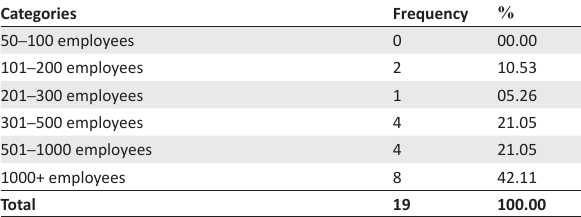
TABLE 2: Number of employees in organisations.